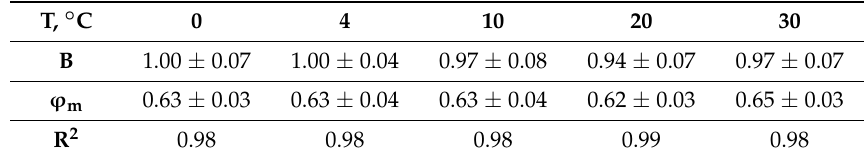
Table 3. Coefficients (B, ϕ m ) of the Krieger-Dougherty equation and the regression coefficient (R 2 ) for fitting